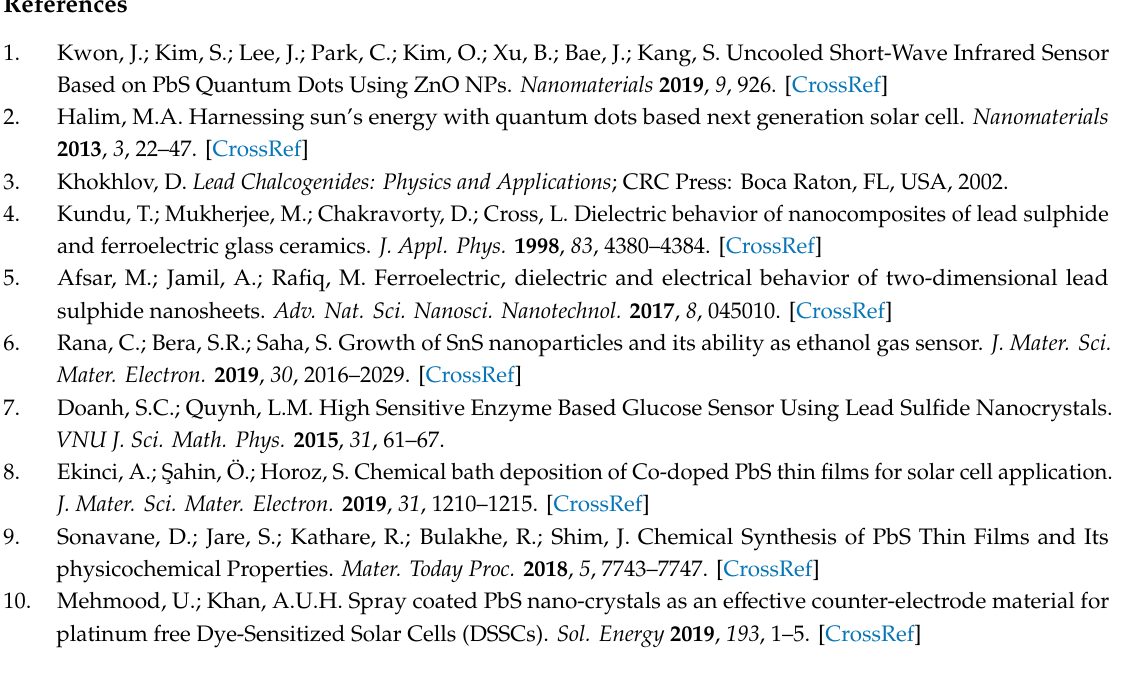
Figure S1: FTIR of bis(diisobutyldithiophosphinato)lead, Figure S2: 1 H-NMR of bis(diisobutyldithiophosphinato)lead, Figure S3: 13 C-NMR of